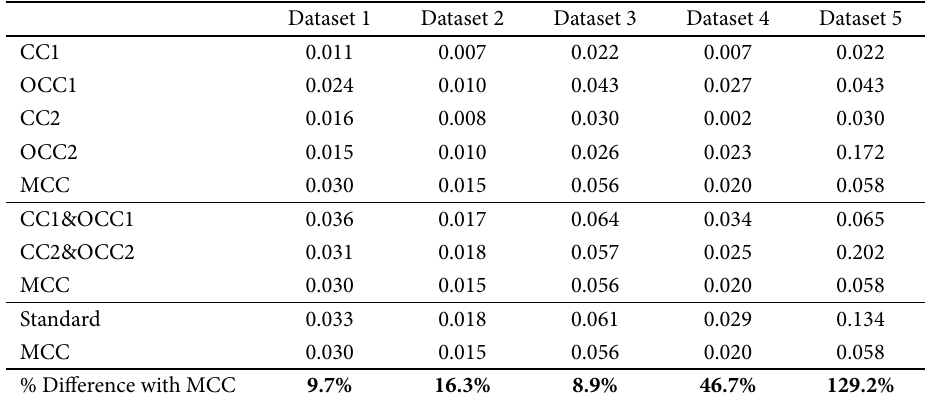
Fig. 7. Overall errors of models for data table 11. Overall errors of models for data sets